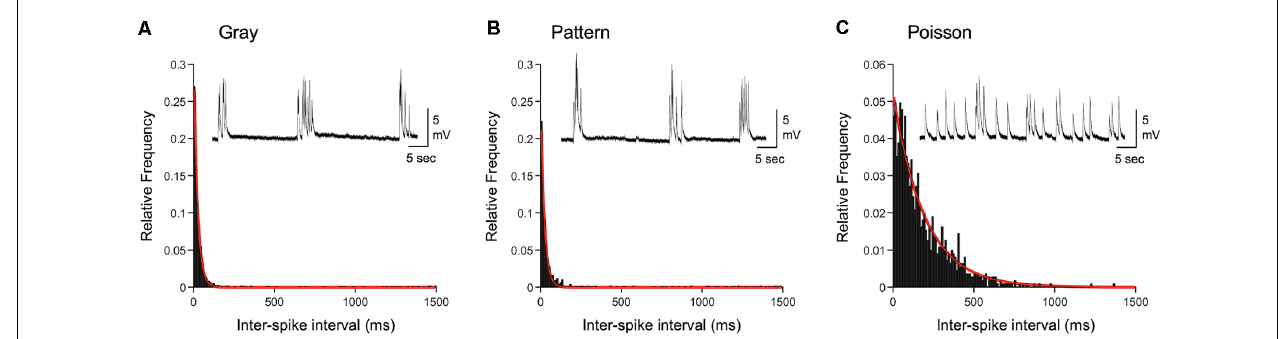
FIGURE 4 | Comparison of inter-spike intervals of naturalistic spike trains. (A) Histogram of inter-spike intervals (ISIs) recorded from L4 of a DE mouse exposed to light and viewing a gray screen (corresponding to +Gray exemplar cell in Table 2 ). The histogram is fitted with a single exponential decay function (red line). Inset: an example current-clamp recording trace from a V1 L2/3 neuron of a DE mouse. Stimulation train from the +Gray exemplar cell was delivered through an electrode placed in L4 of the slice. (B) Histogram of ISIs recorded from L4 of a DE mouse exposed to light and viewing a screen with patterned gratings (corresponding to +Pattern exemplar cell in Table 2 ). The histogram is fitted with a single exponential decay function (red line). Inset: an example current-clamp recording from a V1 L2/3 neuron of a DE mouse receiving a train of +Pattern stimulation through an electrode in L4. (C) Histogram of ISIs of a Poisson train with the same average firing frequency as the exemplar neuron of the Gray group. The histogram is fitted with a single exponential decay function (red line). Inset: an example current-clamp recording from a V1 L2/3 neuron of a DE mouse while delivering a train of +Poisson stimulation (see Table 2 for details) to L4. Note that the stimulation intensity used generates subthreshold EPSPs. Distribution of ISIs between Gray and Pattern is not statistically significant (Kolmogorov–Smirnov test: D = 0.0776, p = 0.009), while that of Poisson is significantly different from those of Gray (Kolmogorov–Smirnov test: D = 0.5530, p < 0.0001) and Pattern (Kolmogorov–Smirnov test: D = 0.4893, p <